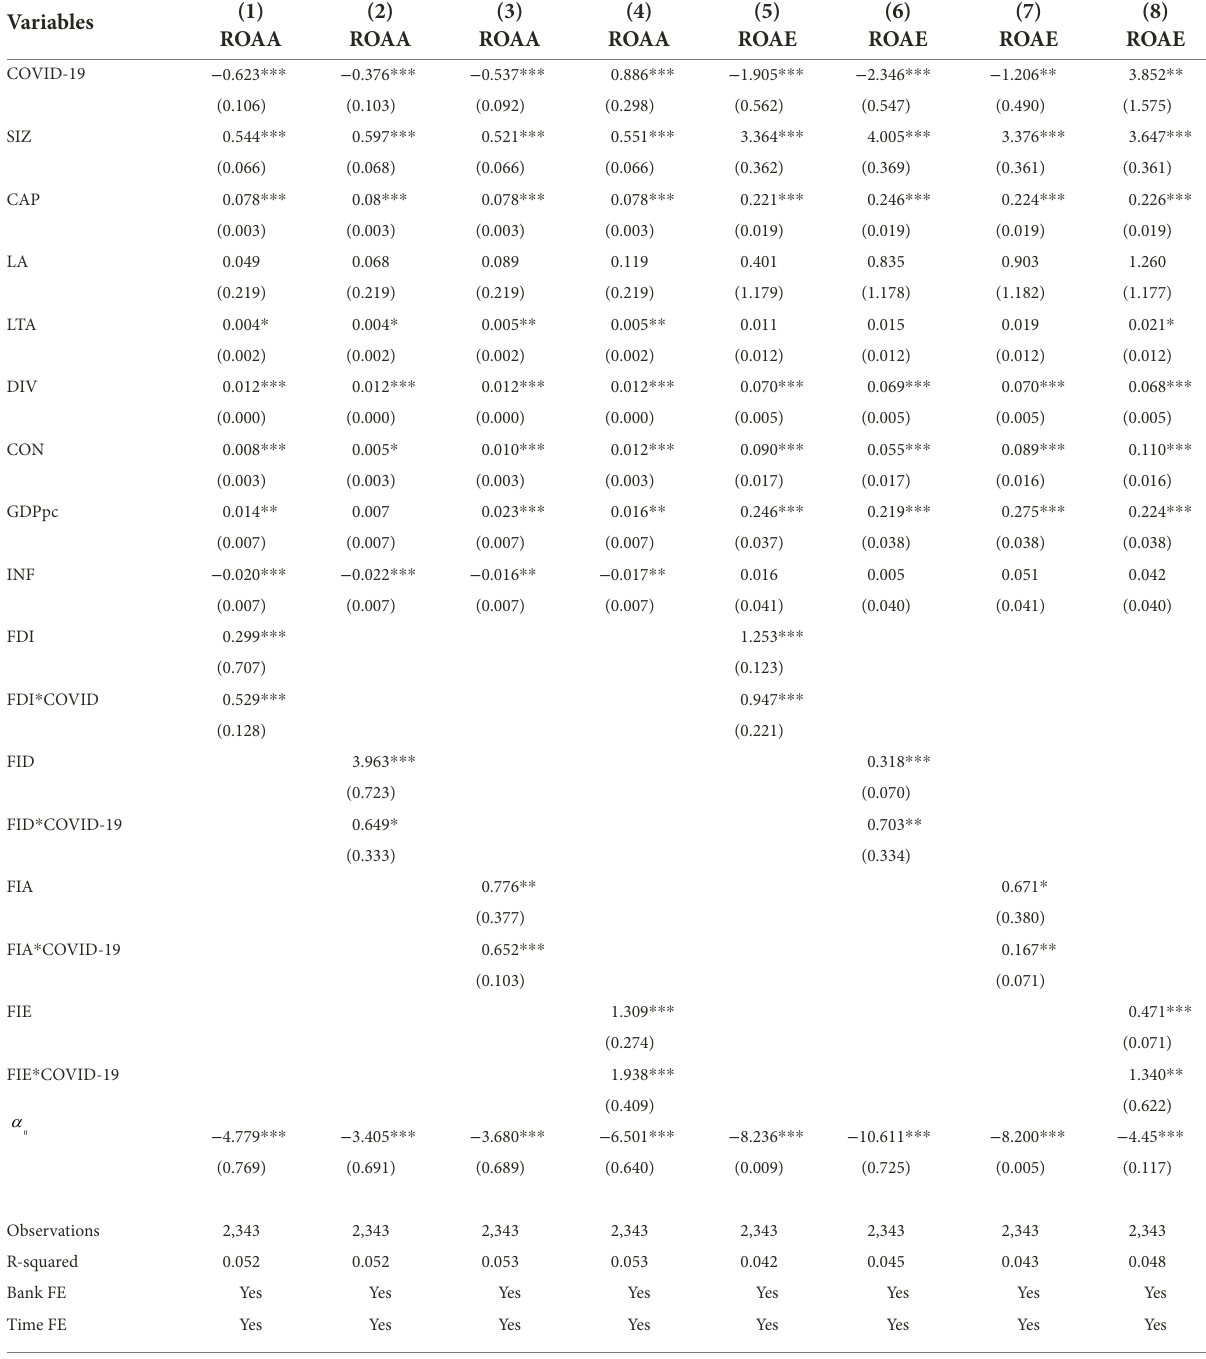
TABLE 6 Bank performance during the COVID-19 pandemic The role of financial development.